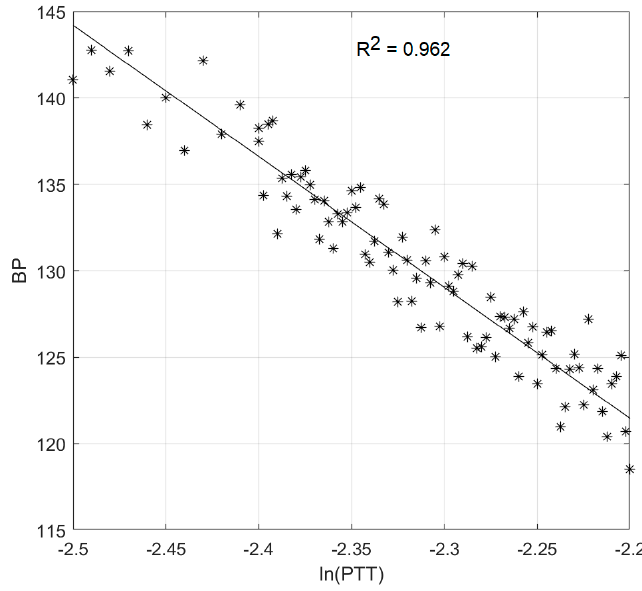
Figure 10. Linear-curve fitting plot of ln(PTT) versus average blood pressure.